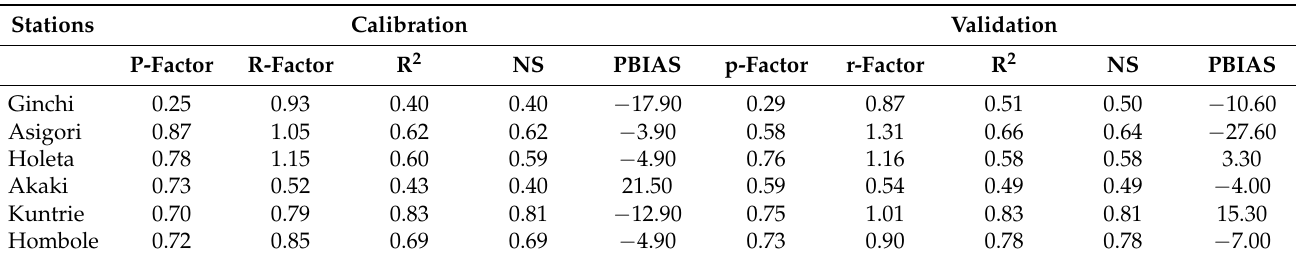
Table 5. SWAT model calibration and validation